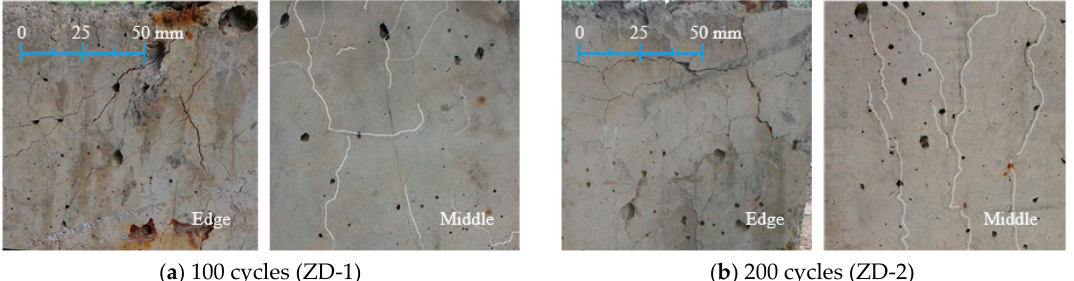
Figure 4. Column surface after freeze–thaw applications.